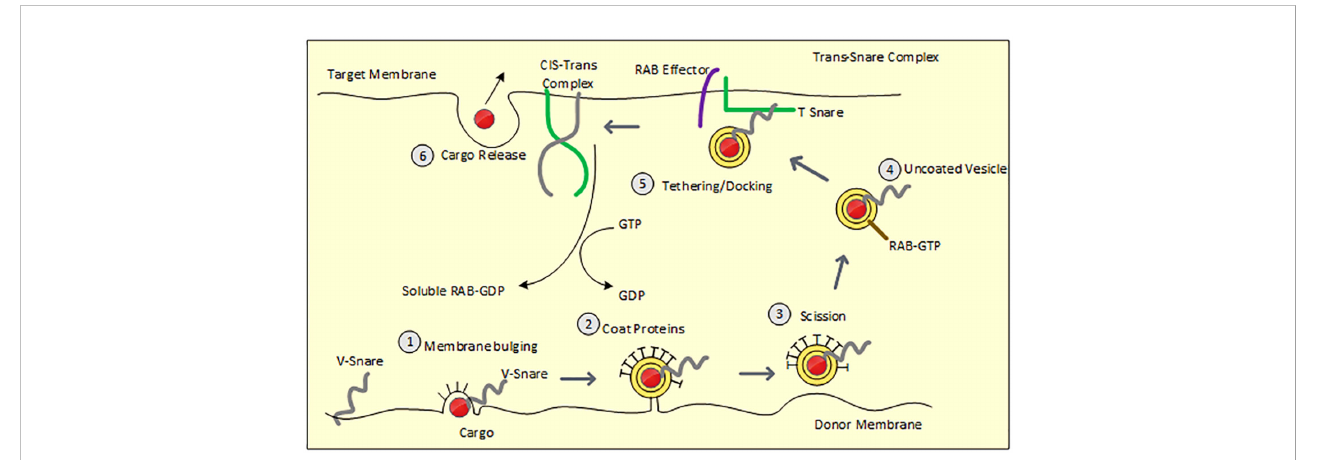
FIGURE 1 Demonstrates steps involved in vesicle budding and fusion. Figure 1 Membrane bulging: Recruited coat proteins line the donor membrane which bulges along with the assembly of cargo and V-SNARE protein. 2. Vesicle budding: Bulged membrane acquires circular appearance with concentrated cargo in the center and is only attached to the donor with a narrow neck. 3. Scission: vesicular neck is severed from the donor membrane 4. Uncoating of vesicles: Vesicle loses coat proteins within the cytosol and naked vesicle reaches the acceptor membrane via cytoskeletal movement 5. Tethering/ Docking: V-SNARE forms an assembly with T-SNARE (acceptor membrane) along with the GTP-bound RAB effector to form a trans-SNARE complex resulting in fusion of the vesicular membrane with the acceptor membrane. Dissociated V-SNARE and T-SNARE from the vesicle form the Cis-Trans complex. 6. Cargo is